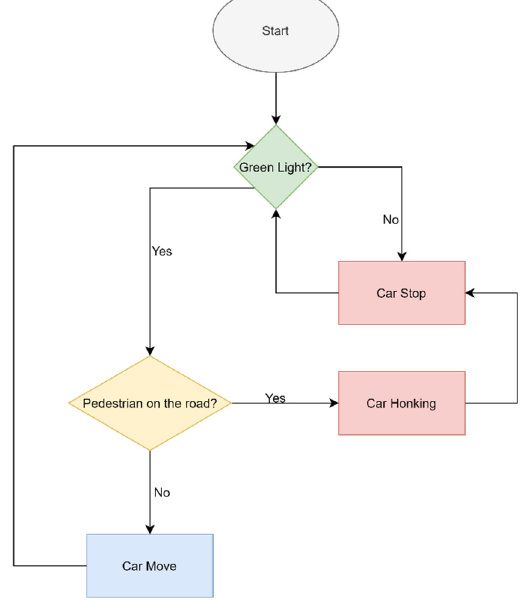
Figure 4. Flowchart of car behaviors in traffic light crossing scene.